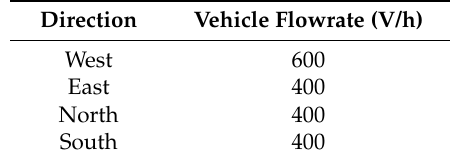
Table 3. Simulation Setting Table.